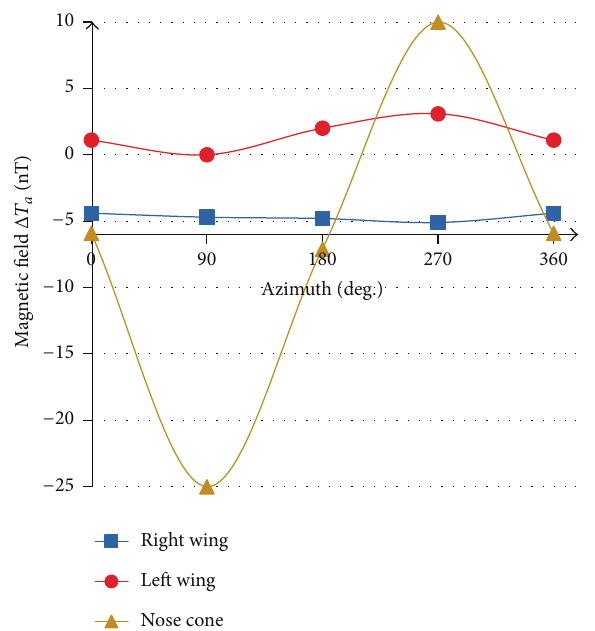
Figure 4: Magnetic deviation of UAV (right wing: blue points on Figure 3; left wing: red points on Figure 3; nose cone: yellow points on Figure